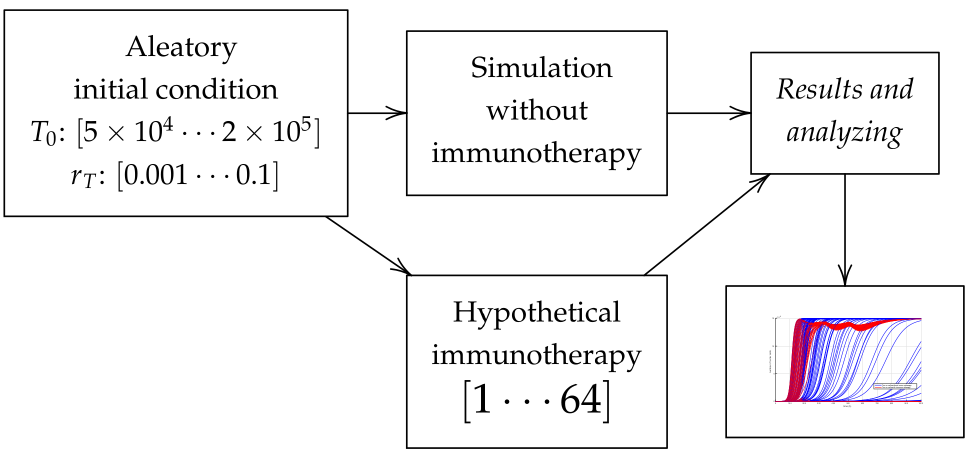
Figure 2. Scheme simulation for hypothetical